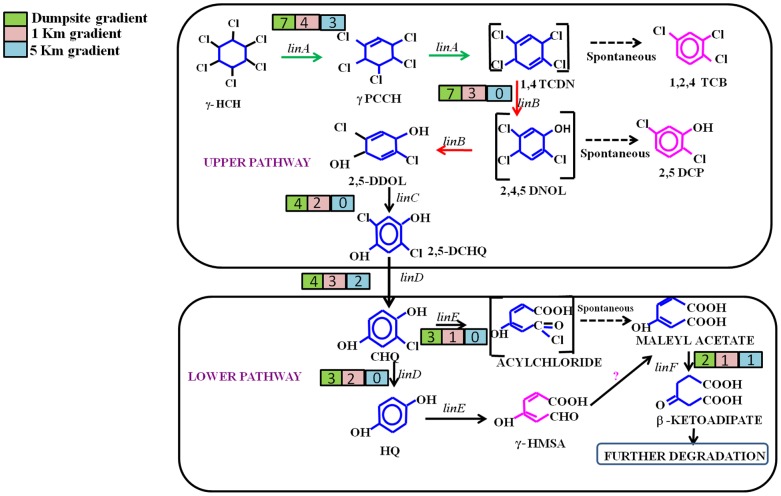
Enrichment of lindane degradation (aerobic) pathway.Schematic representation for the enrichment of aerobic degradation pathway of lindane. Numerical values (on color gradient) at each enzyme represent the diversity (genera) of the corresponding gene present at each metagenome estimated using Transpipe analysis.